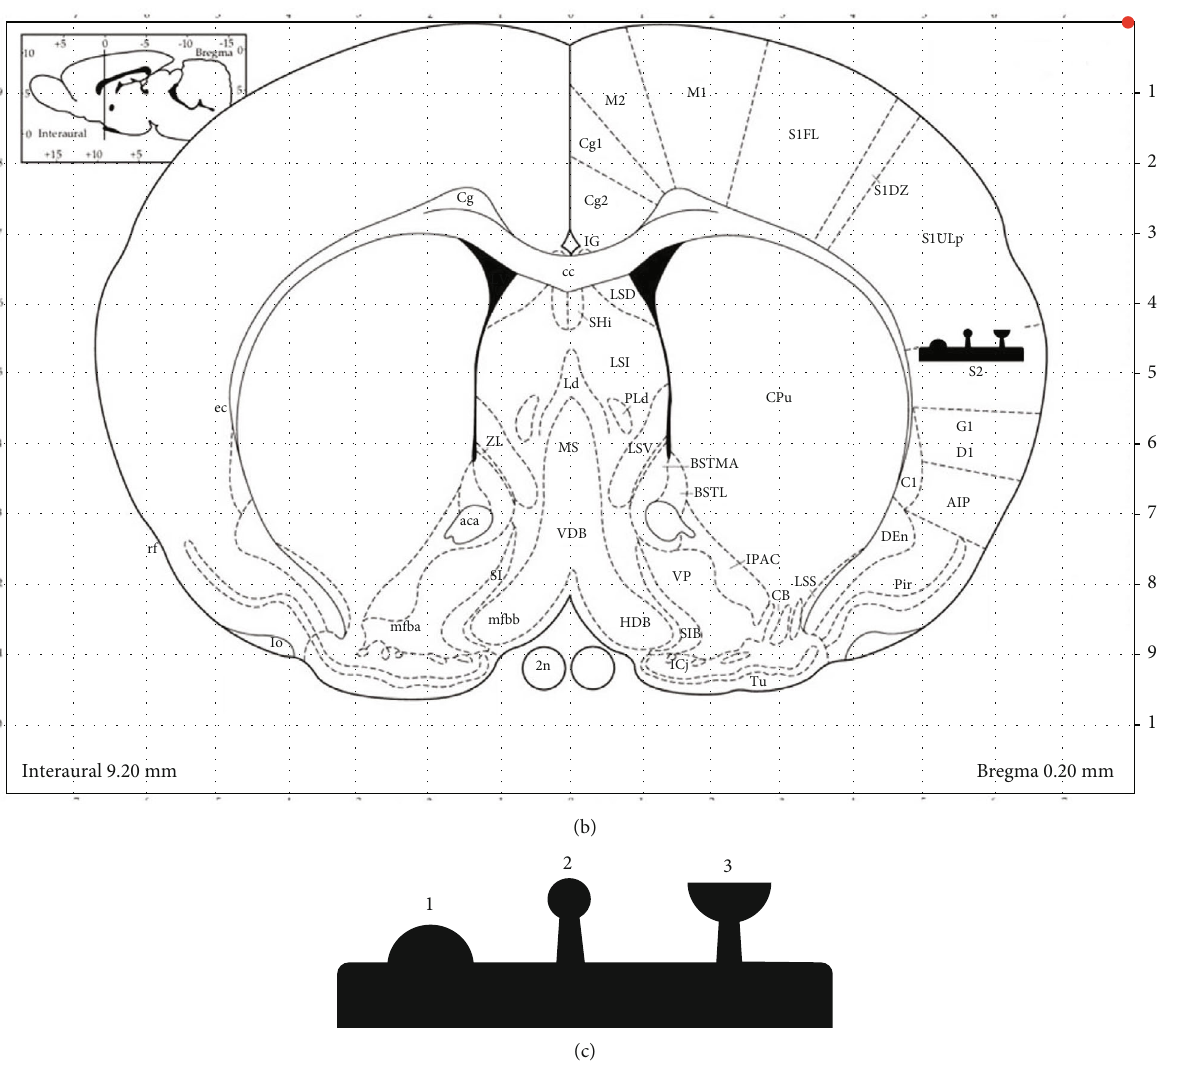
Figure 1: Investigated two areas in the somatosensory cortex are indicated by “ ” icon. (a) The secondary somatosensory (S2) area (AP 0.0 ML 8.0). (b) The edge of the secondary somatosensory area and vibrissae (AP-2.0 ML 7.0) (Paxinos and Watson, 2007). (c) Dendritic spine morphology icon: Stubby (1), thin (2), and mushroom (3) spine